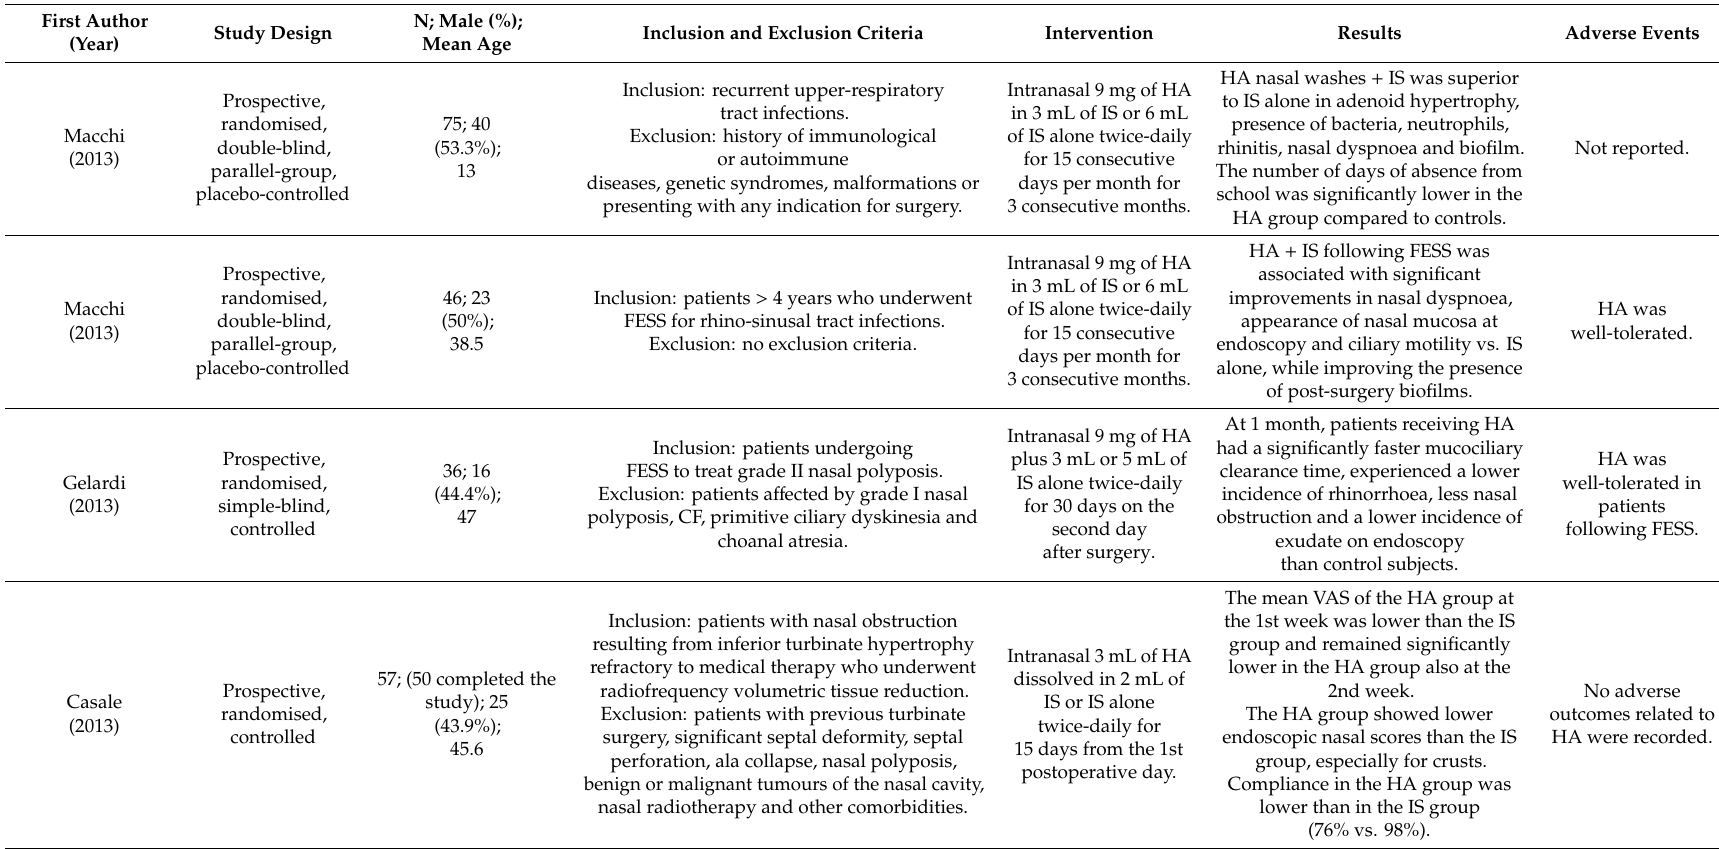
Table 1. Studies of clinical use of topic HA in upper respiratory tract including respiratory infections, rhinosinusitis, and nasal